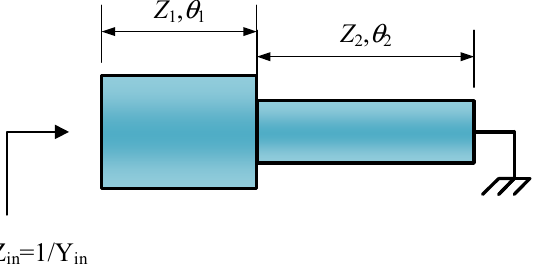
Figure 2. The basic structure of a λ g/4-type SIR.